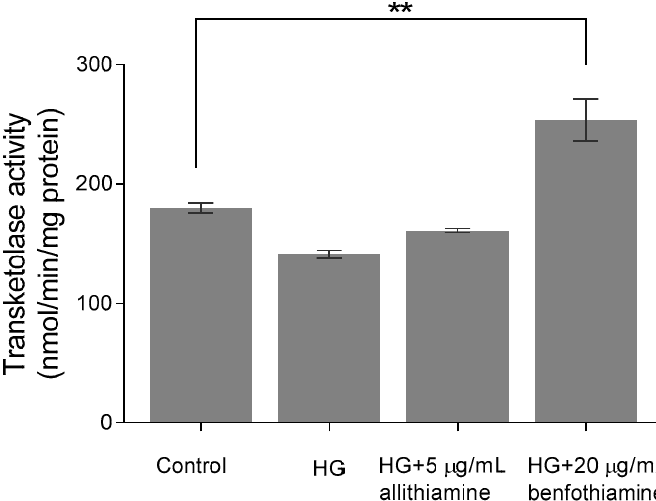
Figure 6. Effect of allithiamine on the level of pro-inflammatory cytokines including IL-6 ( A ), IL-8 ( B ), and TNF- α ( C ) in HUVECs after 6, 12, and 24 h. Data are expressed as the mean ± SEM of three individual experiments *, **, ***, and **** mark significant ( p < 0.05, p < 0.005, p < 0.0005, and p < 0.0001) differences between the control and HG, between HG and HG+5 μ g/mL allithiamine, and between control and HG+5 μ g/mL allithiamine. HG: hyperglycaemia (30 mMol/L glucose).